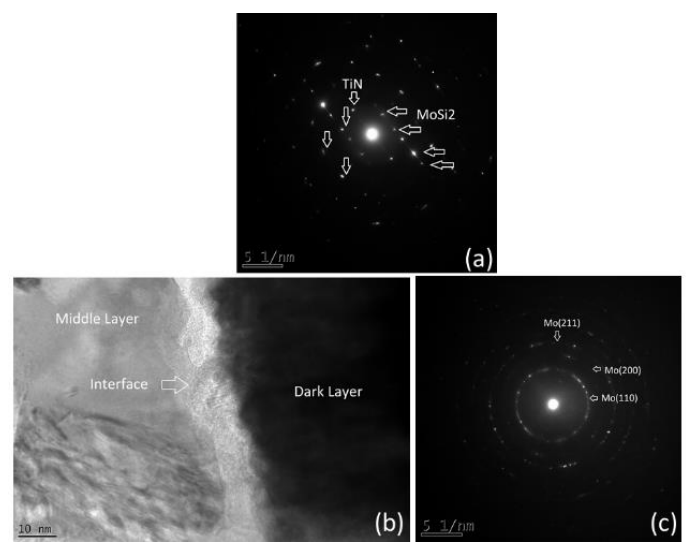
Figure 11. SAED pattern of surface layer and dark layer of the Mo–Ti bilayer film heated at 800 °C and exposed to (Ar-31%N 2 -6%H 2 ) plasma for 1.5 h ( a ) and ( c ), respectively. HRTEM image of the interface between middle layer and dark layer ( b ).